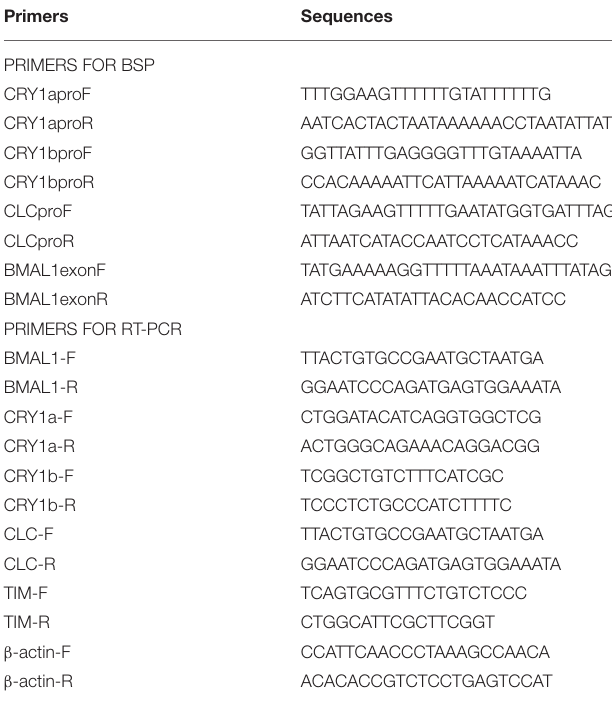
TABLE 1 | Primers used in this